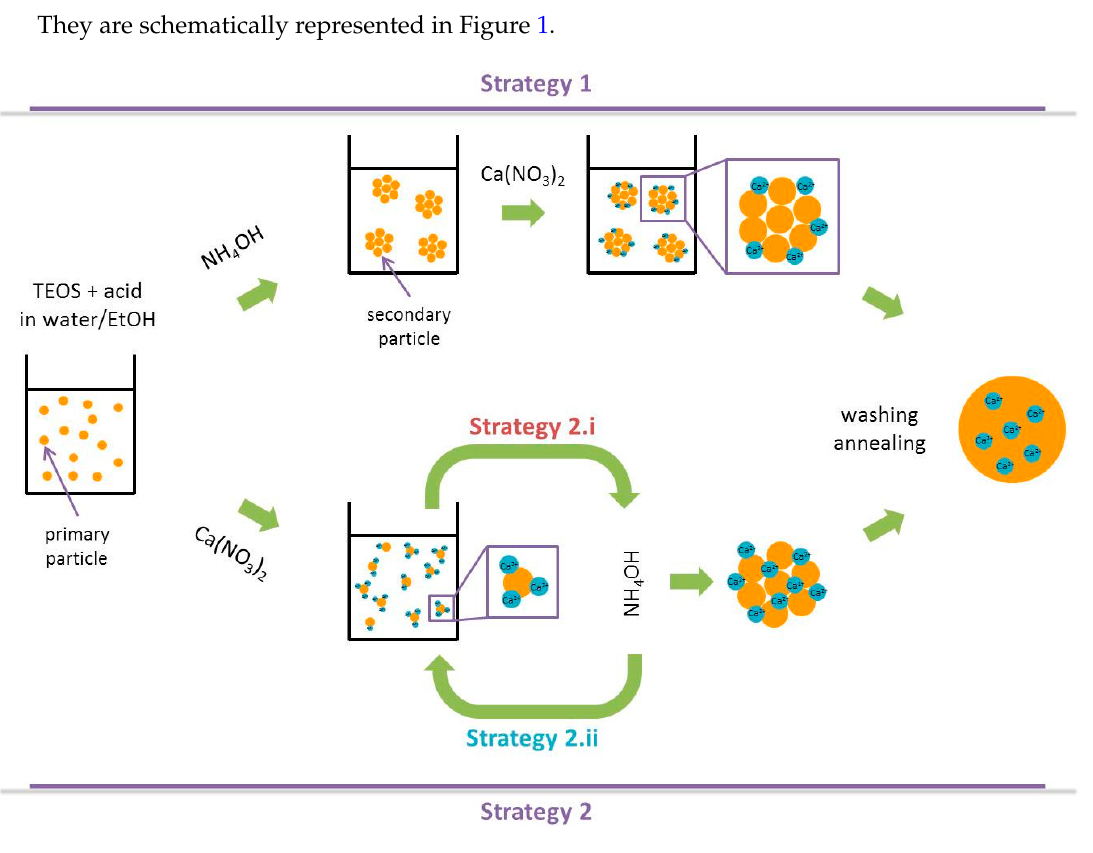
Figure 1. Schematic representation of the different strategies to synthesize binary bioactive glass nanoparticles (SiO 2 -CaO).